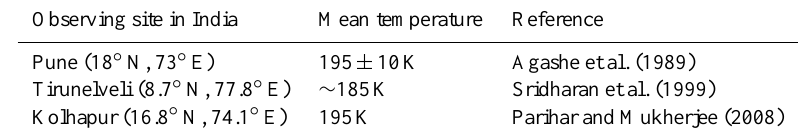
Table 1. Mean temperatures observed in India using the ground-based measurements of OH Meinel Band airglow.